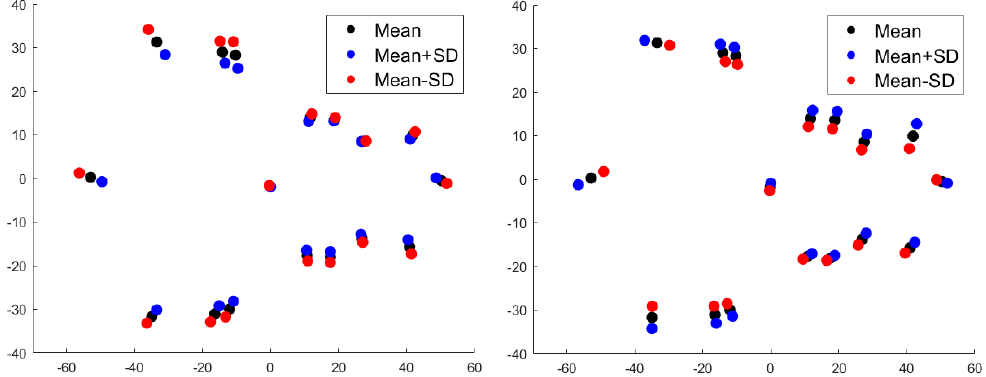
Figure 7. Results for the first two modes of variation using single-level PCA for unscaled shape data for 17 points on the bottom of the crania ( left : first mode; right : second mode). Both modes show some evidence of changes in size, although other subtle changes in shape might occur also, especially for the second mode (Note that axes are measured in mm).